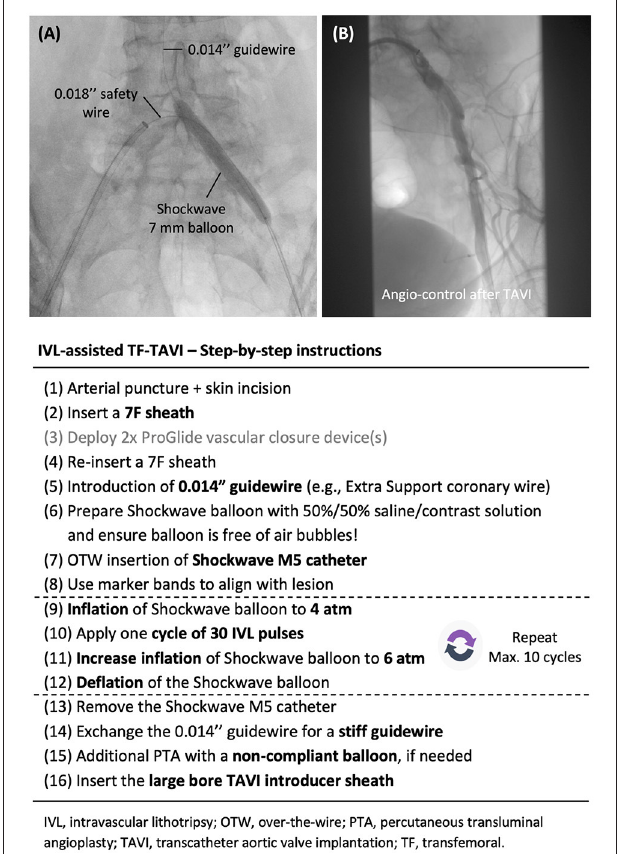
FIGURE 4 | Step-by-step guide. (A) Treatment of a stenotic calcified common iliac artery with a 7mm Shockwave IVL catheter. The use of a contralateral or ipsilateral 0.018” safety wire is strongly recommended. (B) Angiographic control with contrast injection is recommended after withdrawal of the large bore introducer sheath and vascular closure. IVL, intravascular lithotripsy; TAVI, transcatheter aortic valve implantation; TF, transfemoral.